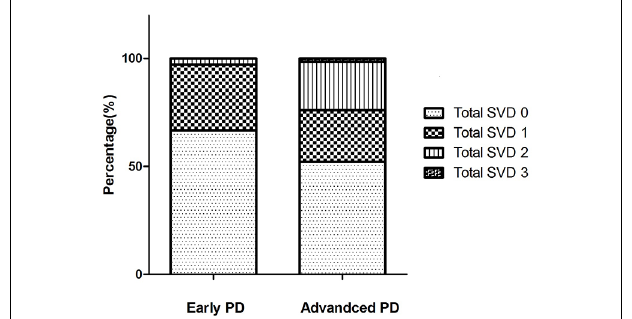
FIGURE 2 | The percentage of different total cerebral small vessel disease (CSVD) scores in the two Parkinson’s disease (PD) subgroups. In early PD group, the total CSVD score 0–3 were present in 66.7%, 30.6%, 2.8%, 0% of the patients, respectively. In advanced PD group, the total CSVD